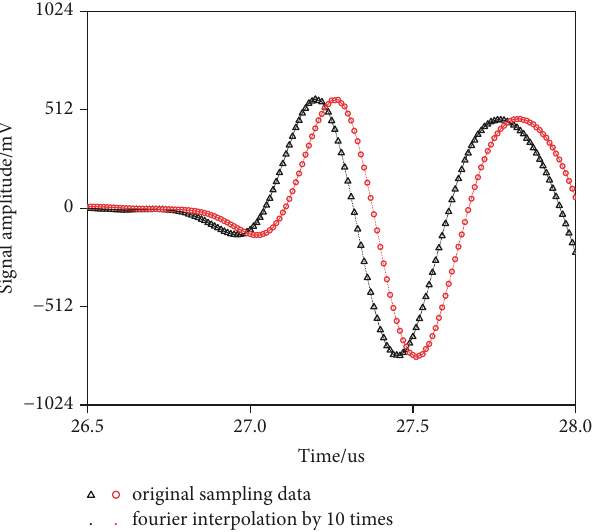
Figure 8: Ultrasonic